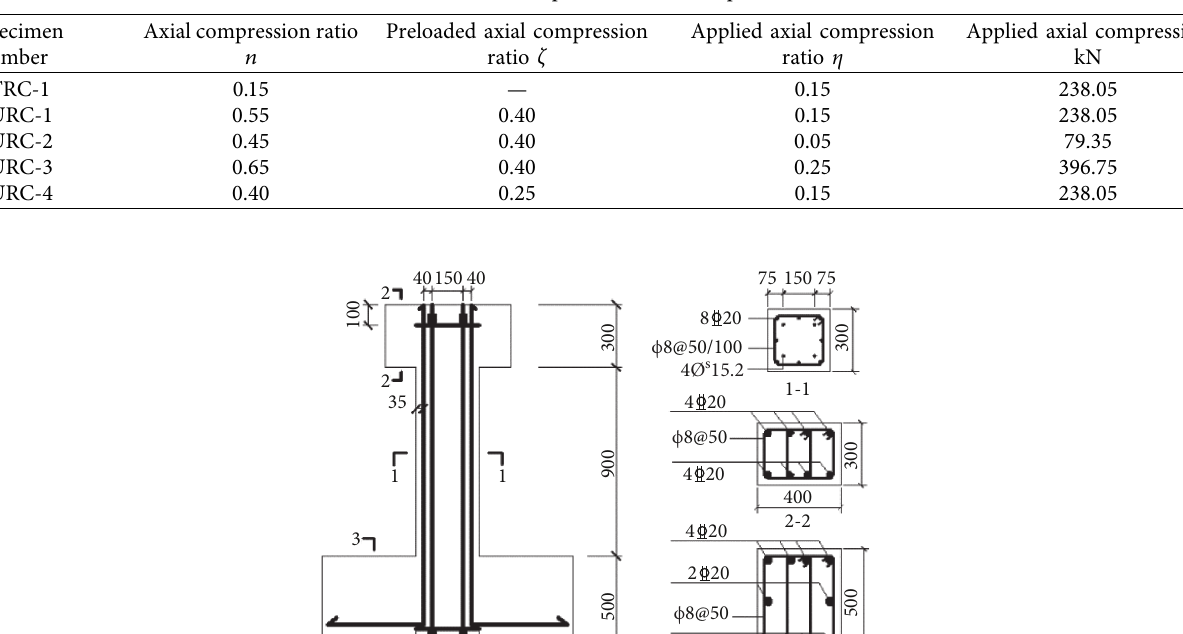
Table 2: Axial compression ratios of specimens.